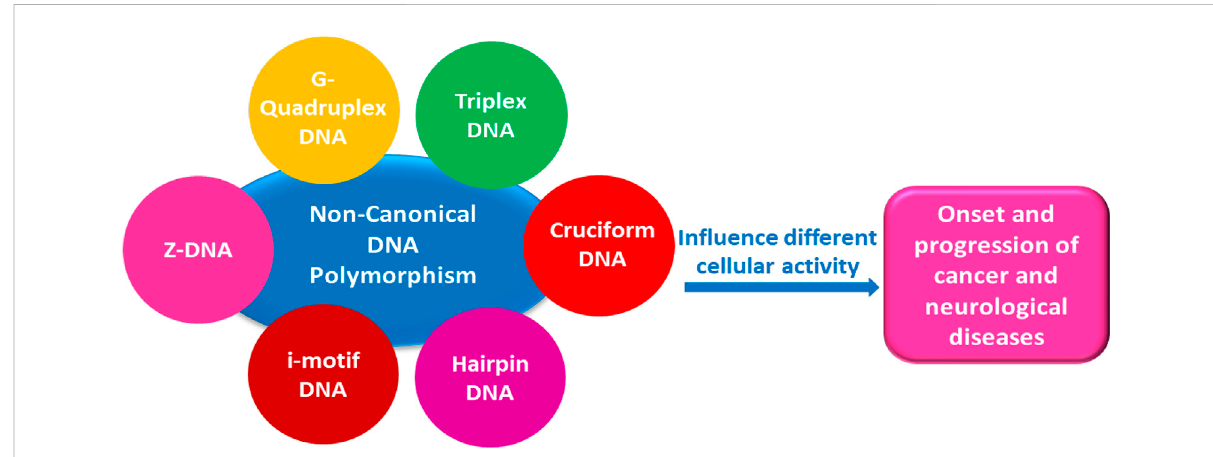
FIGURE 1 Schematic representation of DNA non-canonical structures and the diseases